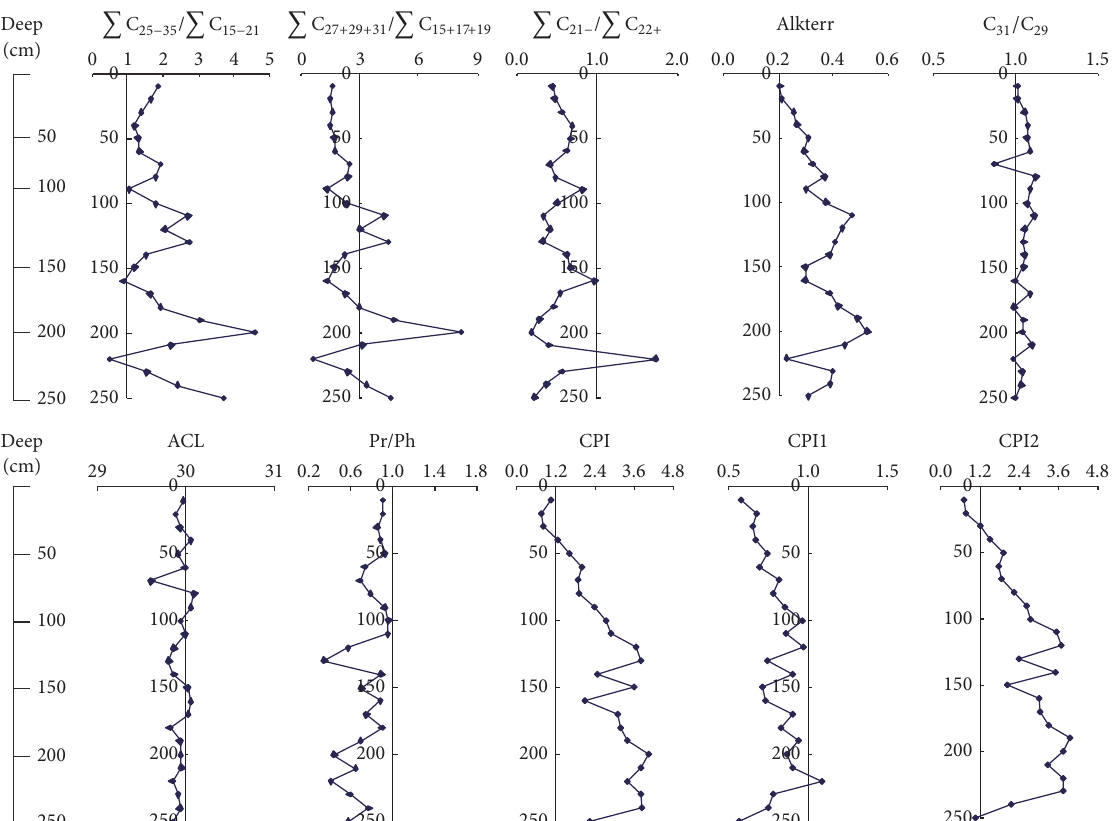
Figure 4: Vertical distribution characteristics of geochemical parameters of n-alkanes of sediment core samples.